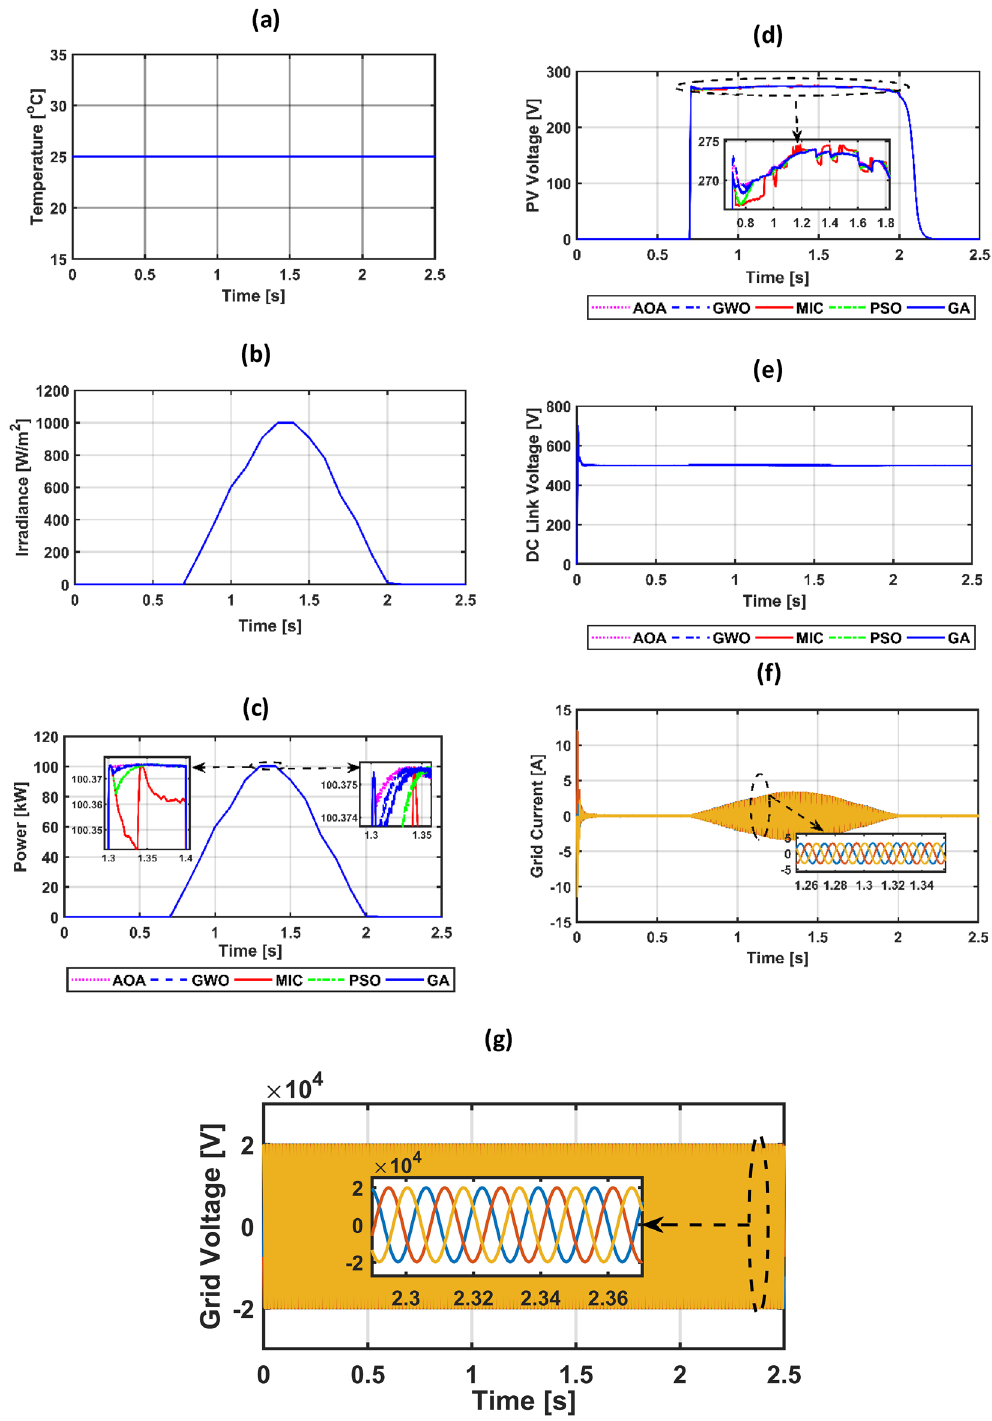
Figure 11. ( a ) fixed temperature, ( b ) different irradiance, ( c ) PV power, ( d ) PV voltage, ( e ) voltage of DC link, ( f ) grid current-based AOA, ( g ) grid voltage-based